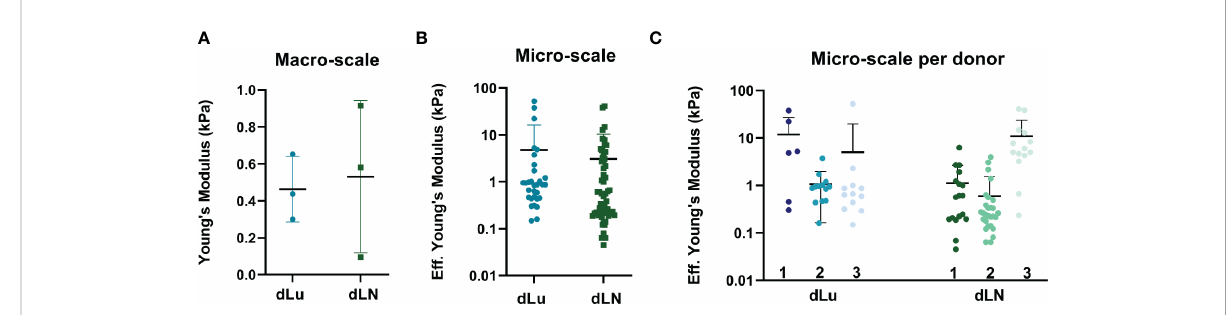
FIGURE 3 Macroscopic and microscopic mechanical characterization of dLu and dLN. (A) Macroscopic compression measurements showing the Young ’ s Modulus of dLu (n=3, dLu1, dLu2, dLu3) and dLN (n=3, dLN11, dLN10, dLN5). (B) Effective Young ’ s Modulus measured by micro-indentation (3x3 matrix scans, 5µm between indentations with a total measured area of 15x15 µm) of dLu (n=3 donors) and dLN (n=3 donors). (C) Effective Young ’ s Modulus measured by micro-indentation split per donor for both dLu (dLu1, dLu2, and dLu3) and dLN (dLN11, dLN10, dLN5). Each data point is a different region of the sample obtained in a 3x3 matrix